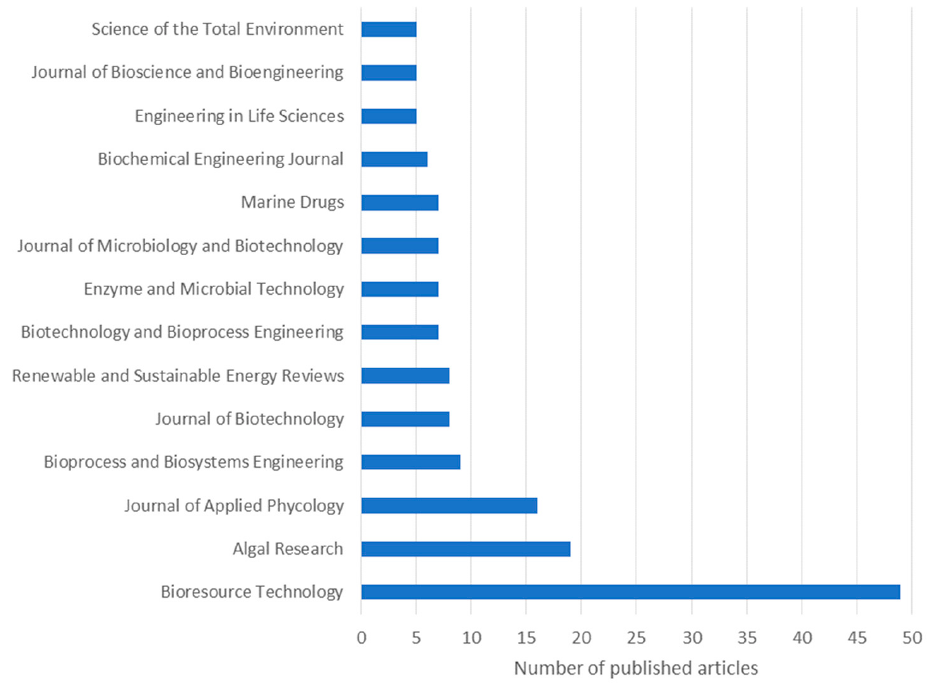
Figure 3. The most productive journals (min. 5 articles).